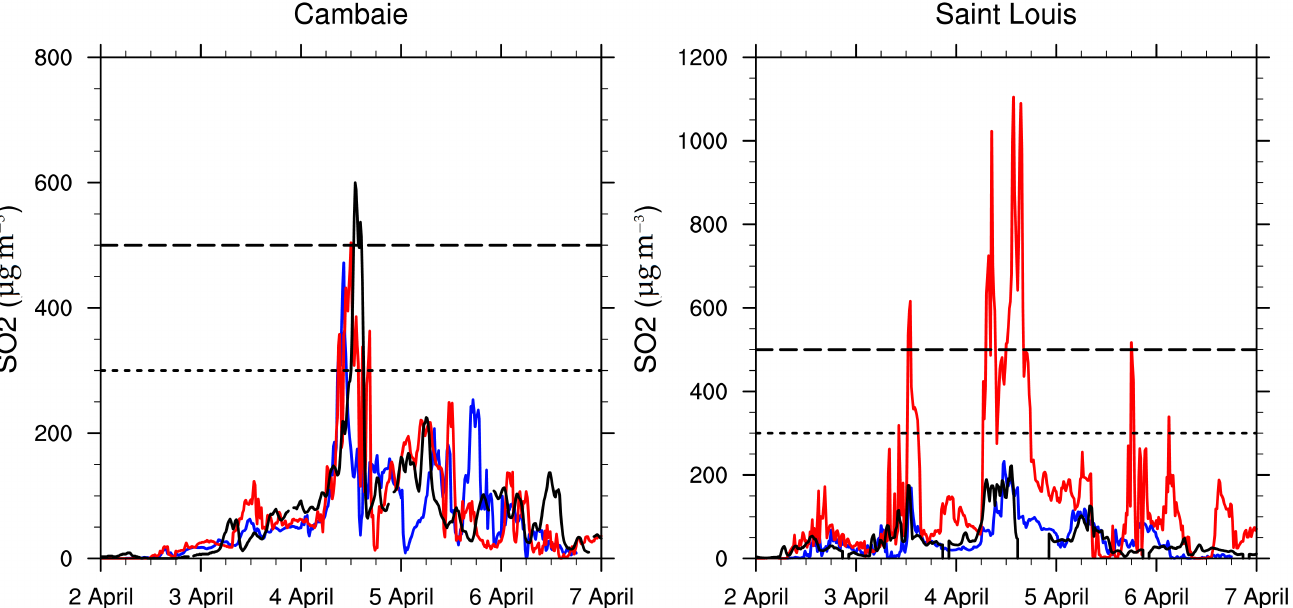
Figure 13. Comparison of the surface SO 2 concentration (µgm − 3 ) observed at the ATMO-Réunion stations in Cambaie and Saint-Louis (Black) with the MesoNH simulation (blue) and previous simulations from in [21] (red) between 2 and 7 April. Dashed lines represent information (300) and health (500) concentration